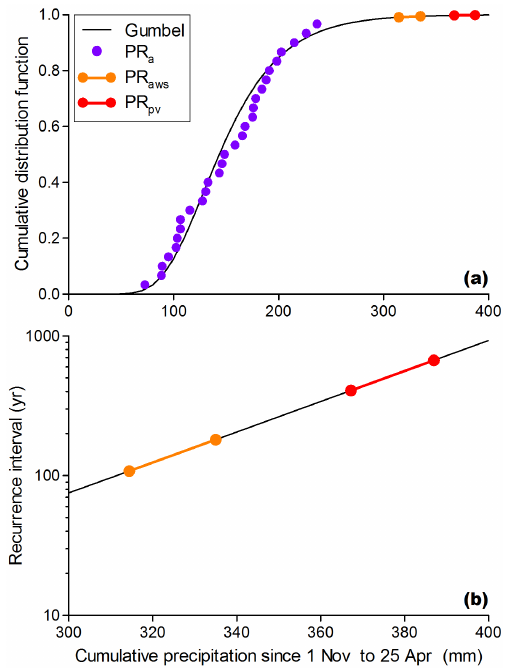
Figure 11. (a) Cumulative density function of cumulative precipi- tation from 1 November to 25 April (PR a , purple circles) and the Gumbel density functions (black line); (b) recurrence interval. Red and orange circles denote calibrated precipitation for the eleva- tion of Kyangjin (3830ma.s.l.) from two sites near Yala Glacier (Fig. 1a), assuming two elevation gradients for precipitation.